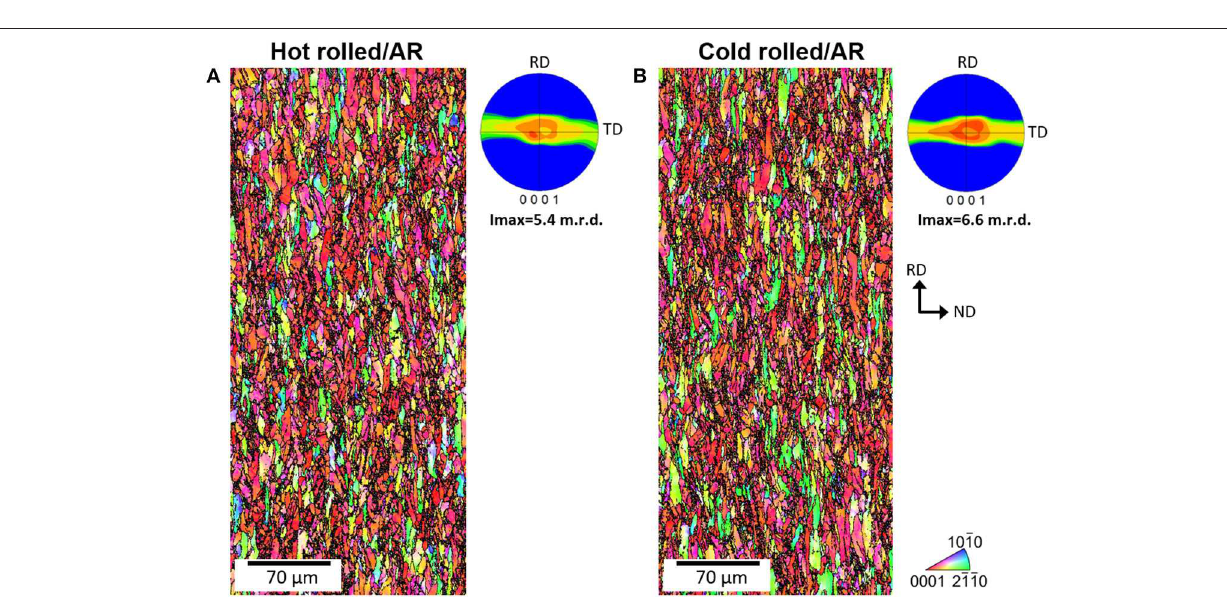
FIGURE 9 | EBSD orientation maps of deep drawn cups made out ZEW200 alloy with a DR = 2.0. (A) Hot rolled/as-rolled condition and (B) cold rolled/as-rolled condition. The approximate position of the EBSD measurement indicated by the red-dotted squares in Figure 8